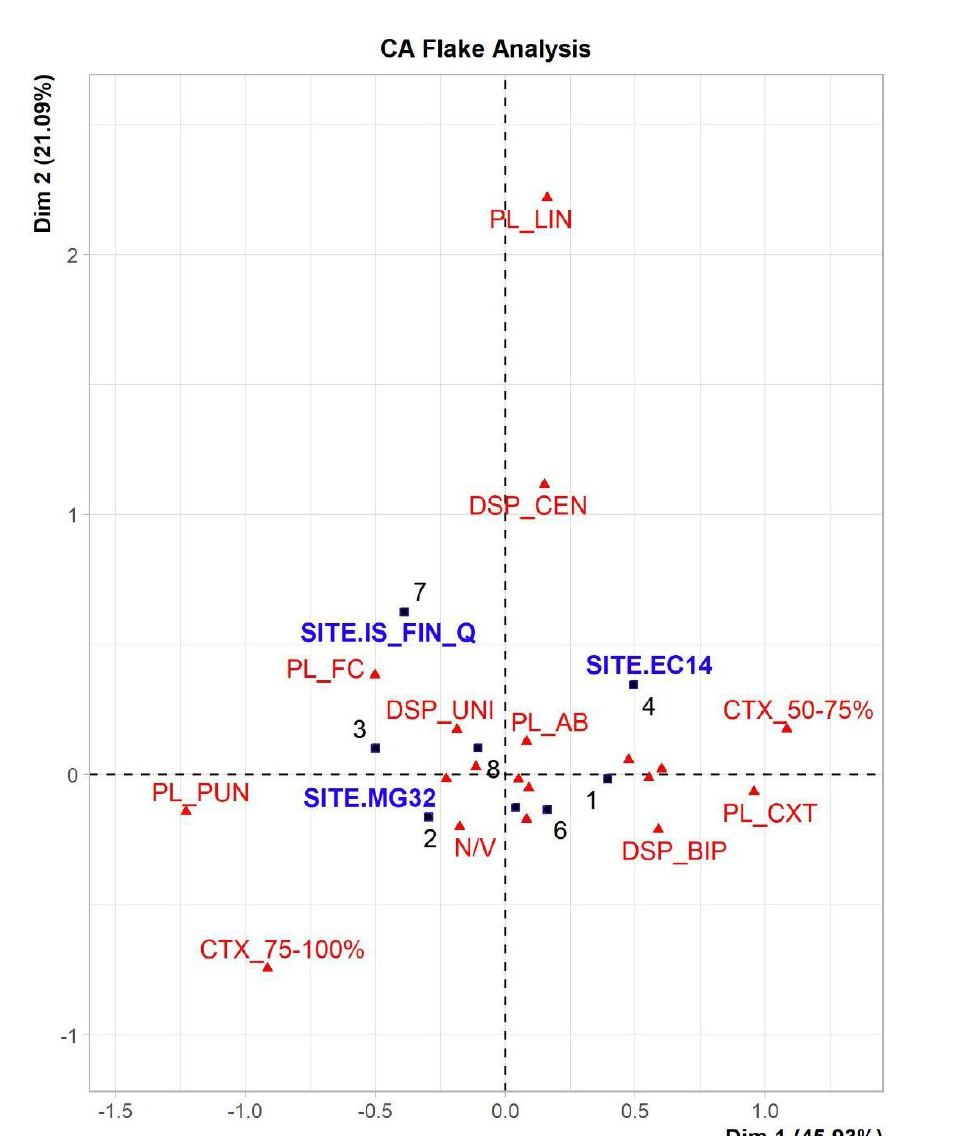
Figure 13. Correspondence analysis of flakes. Supplementary variables are marked in blue while active variables are marked in